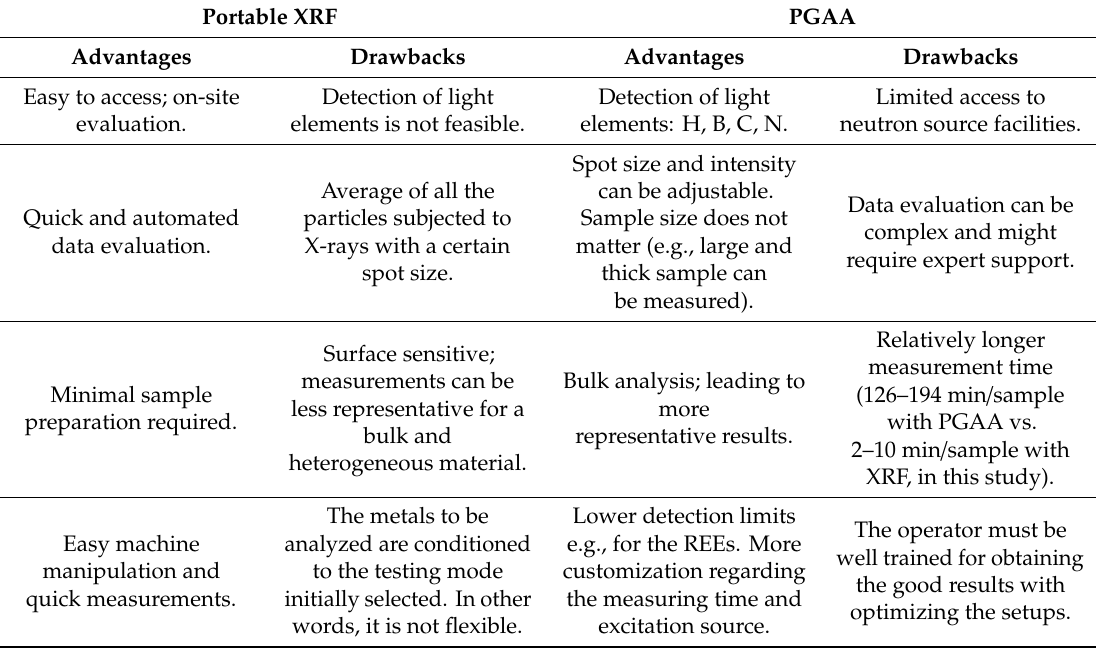
Table 7. Advantages and drawbacks of portable XRF and PGAA for mechanically processed PCB